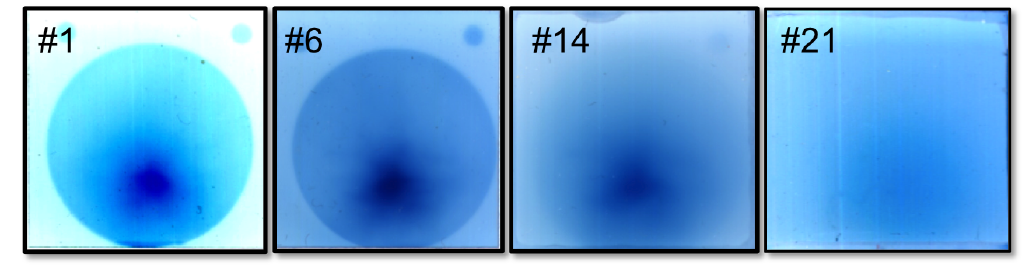
Figure 15. First signals recorded by the SHEEBA detector after exposure to accelerated electrons over 30 laser shots after laser irradiation of a 4 mm nitrogen gas-jet at an intensity of 2 × 10 18 W/cm 2 . According to these data, signal is found up to the last layer of the detector, which indicates average electron energy in the 100 MeV range.